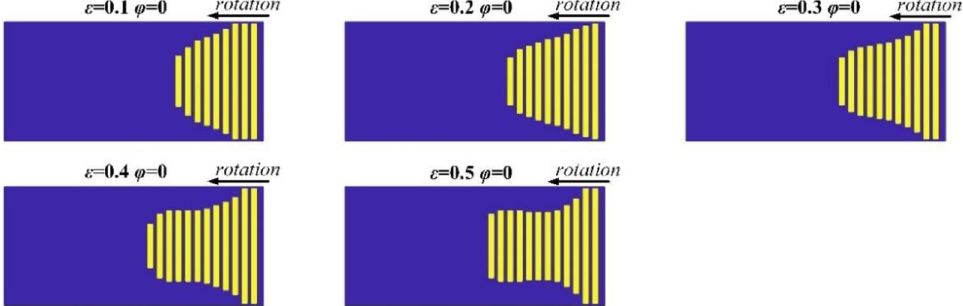
Fig. 14. The optimal groove textures under e =0.1 – 0.5, ’ = 0, N =